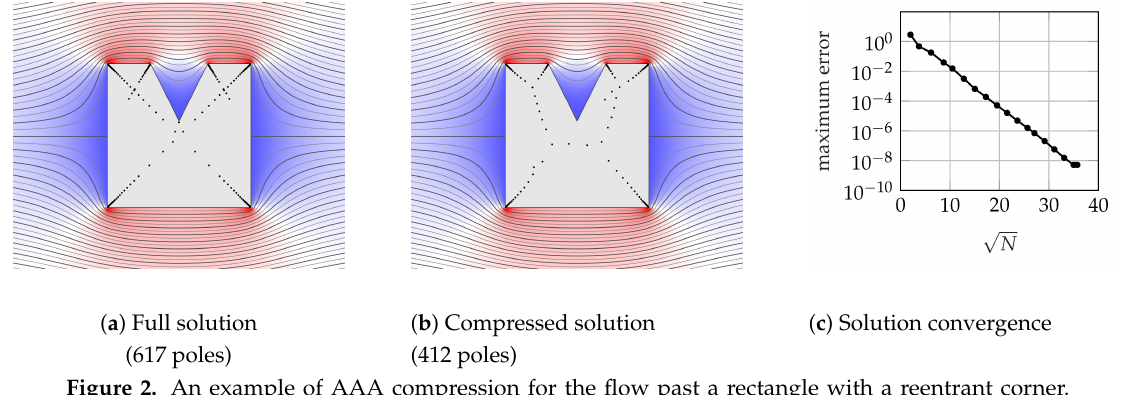
Figure 2. An example of AAA compression for the flow past a rectangle with a reentrant corner. The black dots in ( a ) and ( b ) indicate the poles used to represent the full and compressed solutions